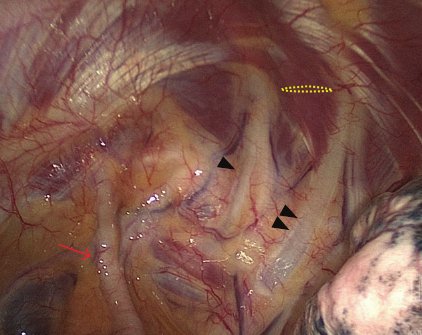
Figure 1: Radiographic images and schematic of vascular injury.